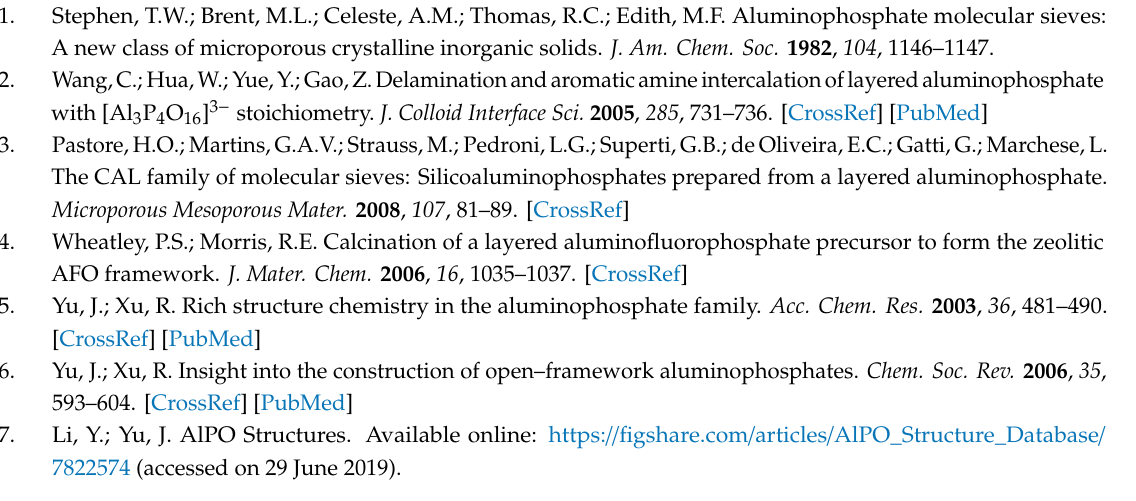
Supplementary Materials: The Supplementary Materials are available online. Figure S1: IR spectrum of SYSU-6 with the range of 400–4000 cm − 1 ; Figure S2: UV Raman spectrum excited with 325 nm of SUSY-6 with the range of 200–1200 cm − 1 ; Figure S3: The solid-state 13 C MAS NMR of SYSU-6 and the 13 C Liquid NMR of synthetic protonated N , N ,3,5-tetramethyladamantan-1-amine dissolved with concentrated HCl aqueous